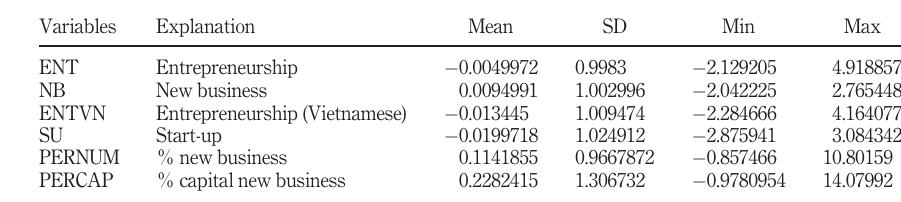
Table I. Statistical description